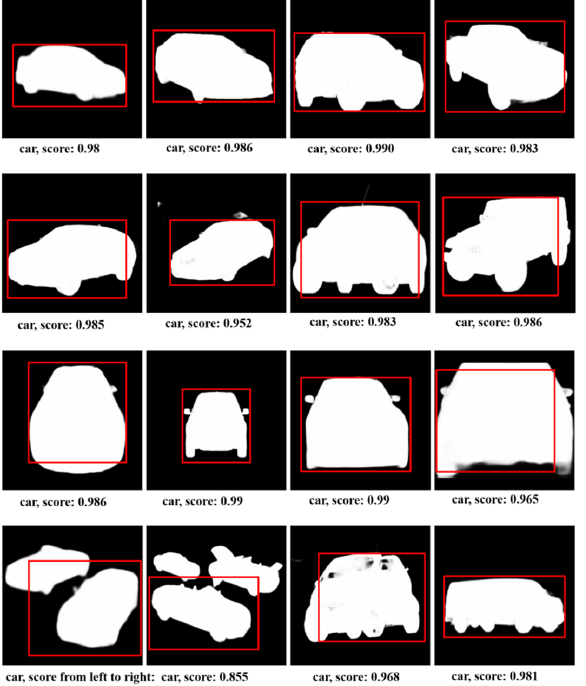
Figure 4. The 16 representative car contour shape maps were selected from the test set with their confidence and predicted bounding boxes.